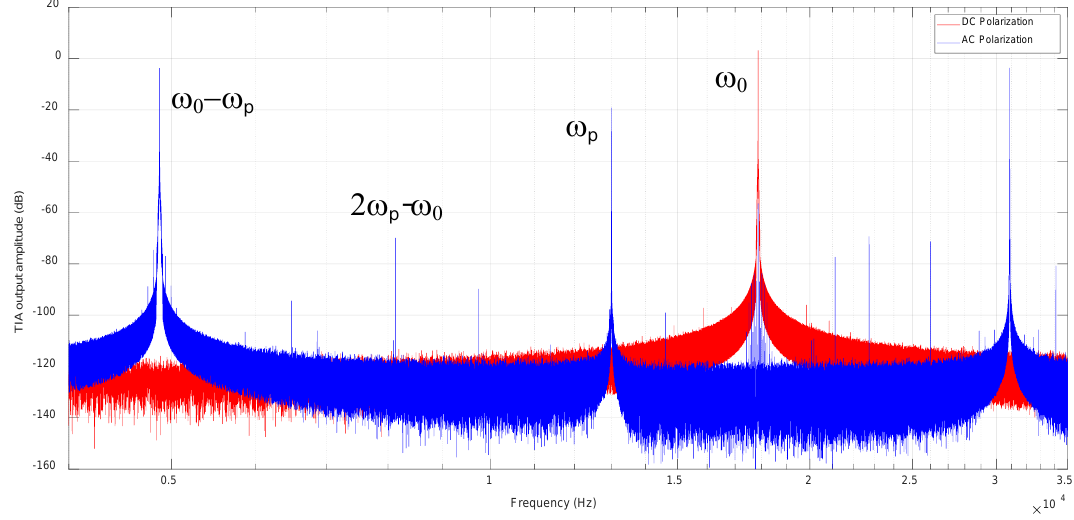
Figure 7. Frequency spectrums of TIA output voltage, VDS(t) under DC and AC polarization.